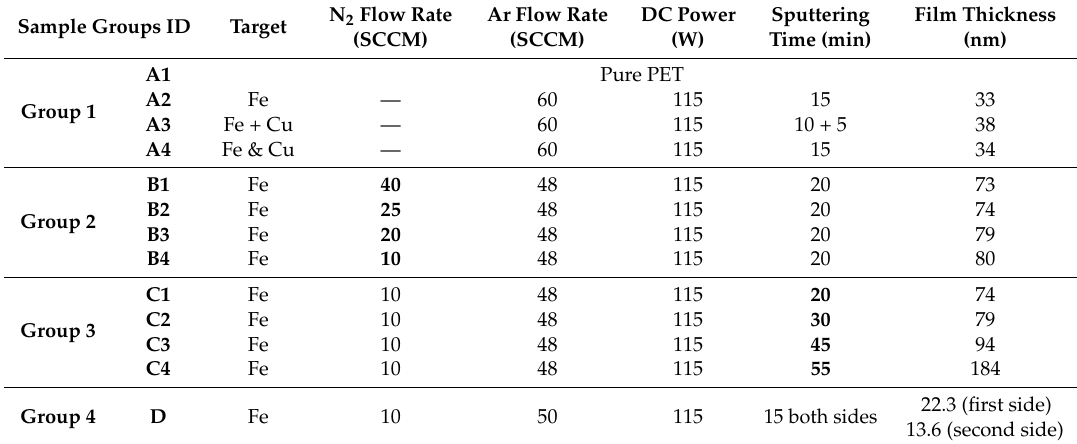
Figure 1. The schematics of dual power (DC/RF) multi target magnetron sputtering system used. Table 1. Variable processing parameter sample ID’s during deposition. Table 1. Variable processing parameter sample ID’s during